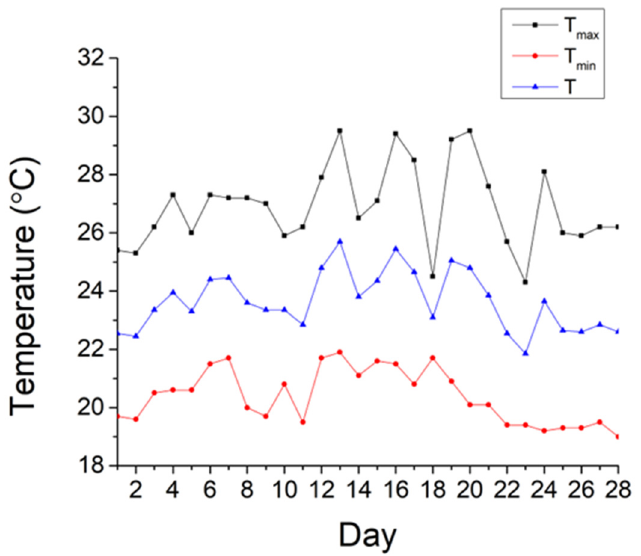
Figure 2. The average value of daily temperature (T) measured at the Jorge Chavez airport in February 2018, along with maximum (Tmax) and minimum daily temperature (Tmin).